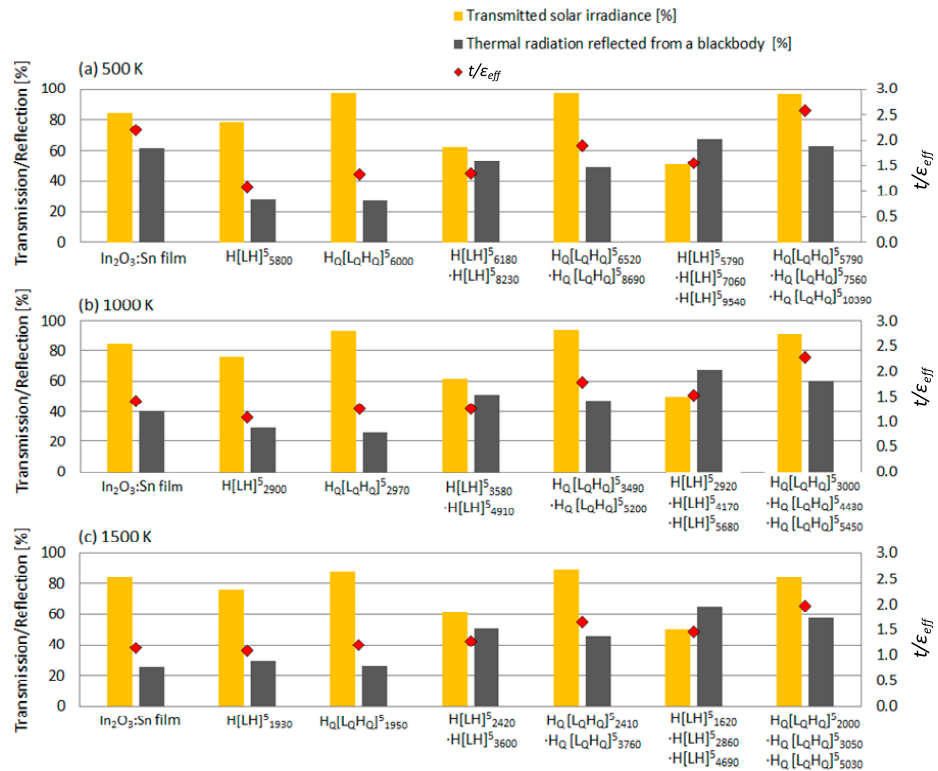
Figure 5. The percentage of the solar irradiance transmitted through a In 2 O 3 :Sn reference film and single and triple-stacked transparent photonic crystal heat mirrors (TPCHMs) (yellow bars) in comparison to the percentage of radiation from a black body (gray bars) at ( a ) 500 K, ( b ) 1000 K, and ( c ) 1500 K that is reflected by these films. For all cases, the value of t / ɛ eff is indicated by the red diamonds (right axis).